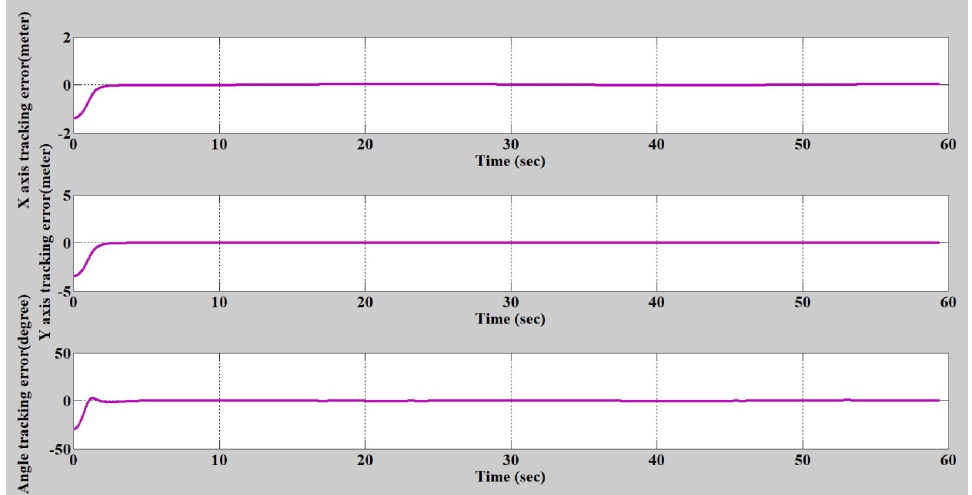
= 0 m, y = 1.9 m). c c